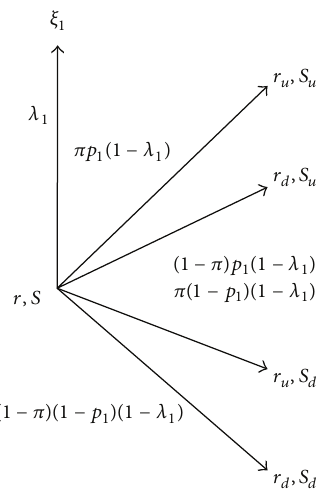
Figure 3: 4-period two-factor binary tree with credit risk